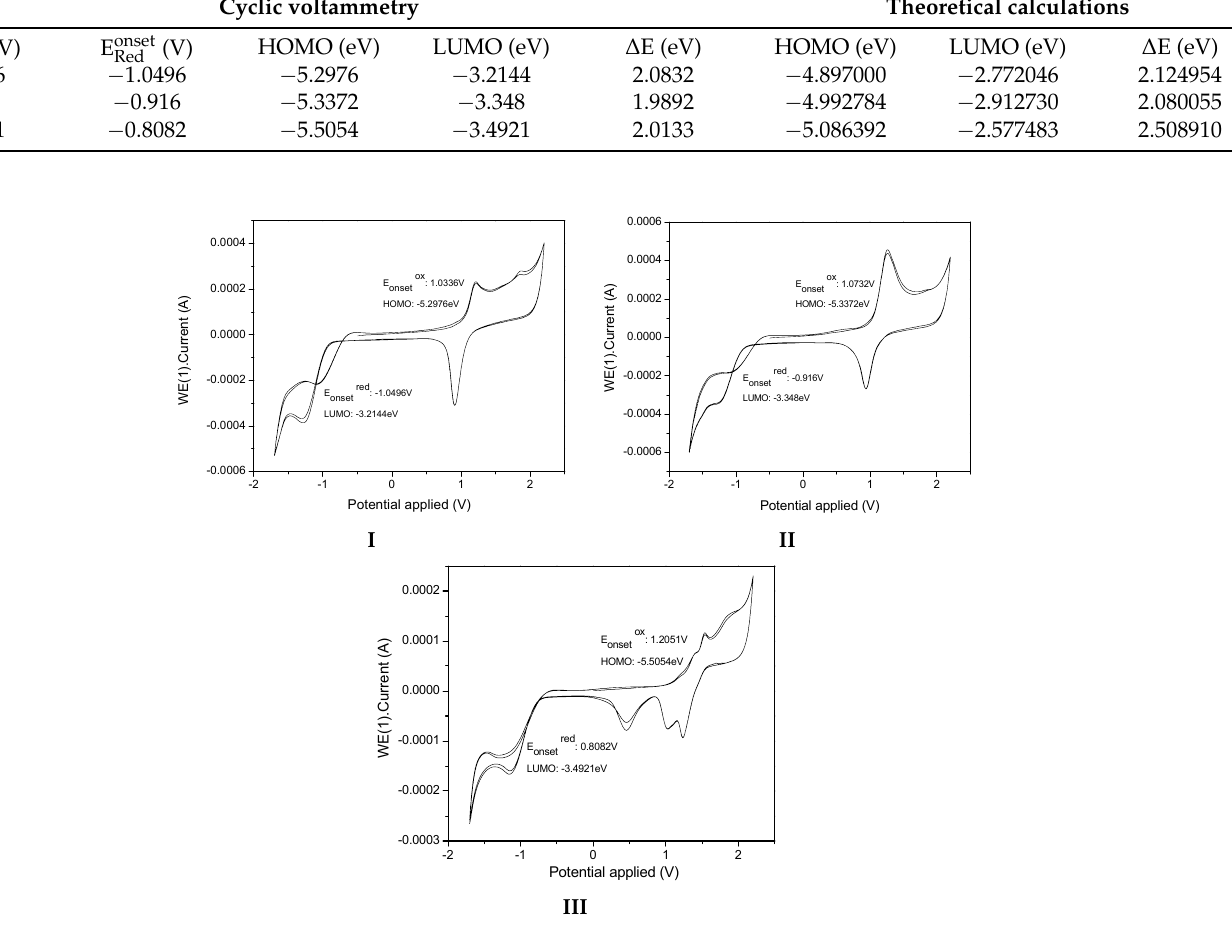
Figure 12. Cyclic voltammograms of I , II and III in 1 mM in 0.1M TBAFP 6 /CH 2 Cl 2 solution with Ag/AgCl as reference electrode and a Pt wire as the working electrode. A scan rate of 50 mVs − 1 was used.